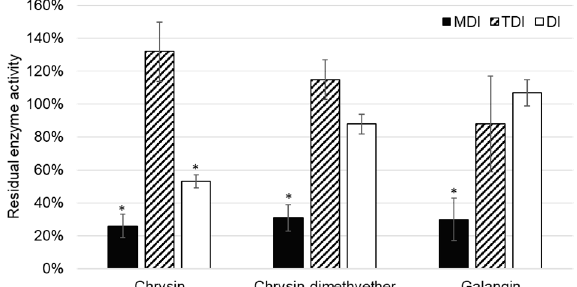
Figure 5. Residual CYP2C8 enzyme activity after incubation with 1 µM flavonoid in the experiments for determination of metabolism dependent inhibition (MDI), time dependent inhibition (TDI), and direct inhibition (DI). * denotes that observed inhibition is statistically significant ( p < 0.05) when compared to the control (without addition of flavonoid).